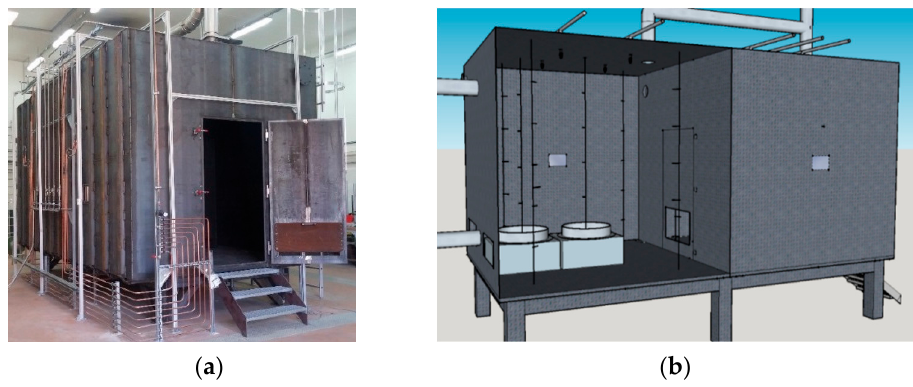
Figure 5. ( a ) Picture and ( b ) schematic of the DIAMAN device.